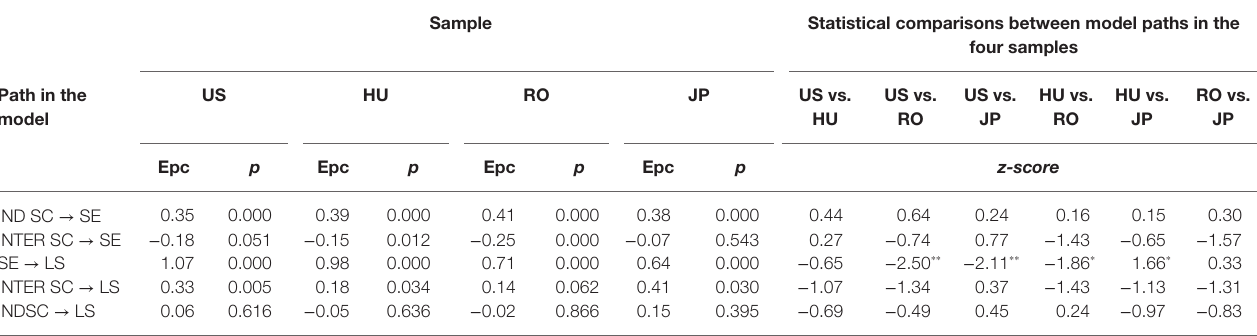
TABLE 4 | Differences in the paths of the model between the four cultural samples in Study 1.